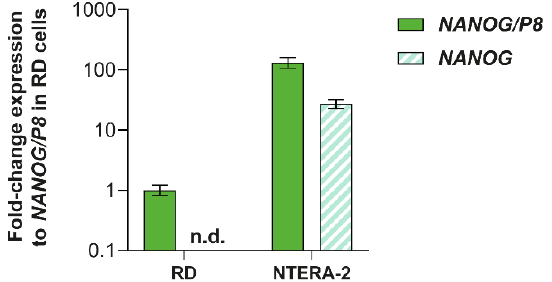
Figure 6. Expression levels of NANOG and NANOGP8 in RD and NTERA-2 cell lines. The relative expression was analyzed by RT-qPCR using NANOG -specific primers ( NANOG ) and primers, which detect both NANOGP8 and NANOG transcripts ( NANOG / P8 ). Expression was normalized to the endogenous control, HSP90AB1 , and the fold-change expression values are presented as the mean ± SD from three biological replicates.